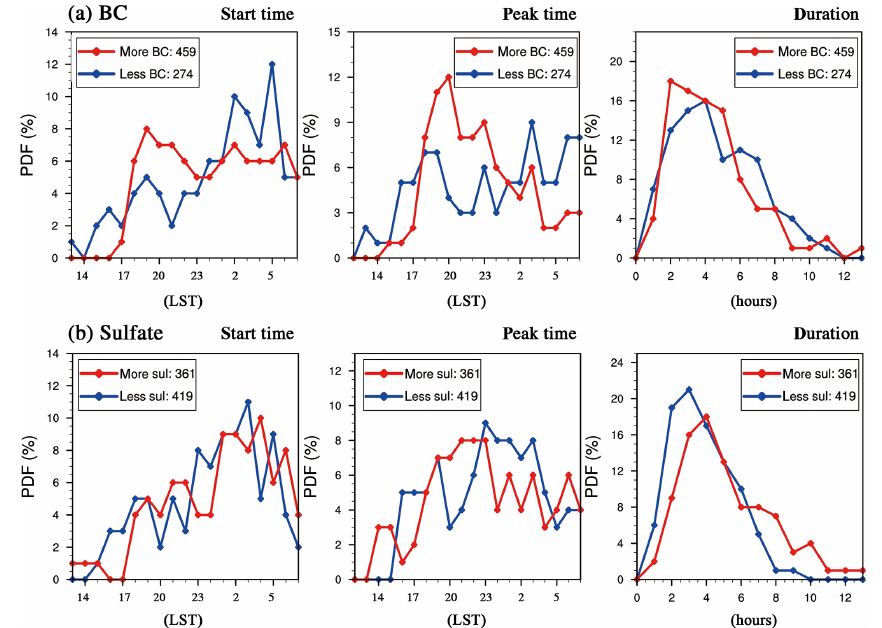
Figure 6. PDFs of start time (units: LST), peak time (units: LST) and duration (units: hours) of heavy rainfall on the different conditions of (a) BC and (b) sulfate. Blue/red lines stand for the condition of less/more BC or sulfate (AOD of BC or sulfate less than the 25th/more than the 75th percentile, data from MACC) during early summers from 2003 to